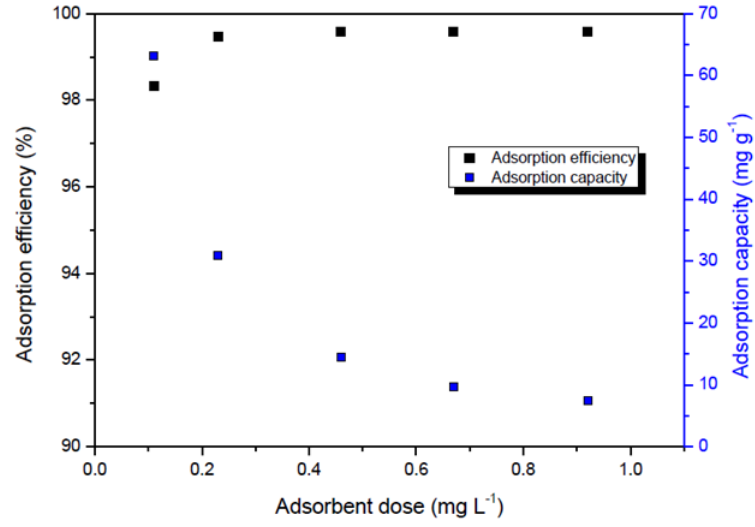
Figure 1. Adsorption efficiency/capacity versus the adsorbent dose.